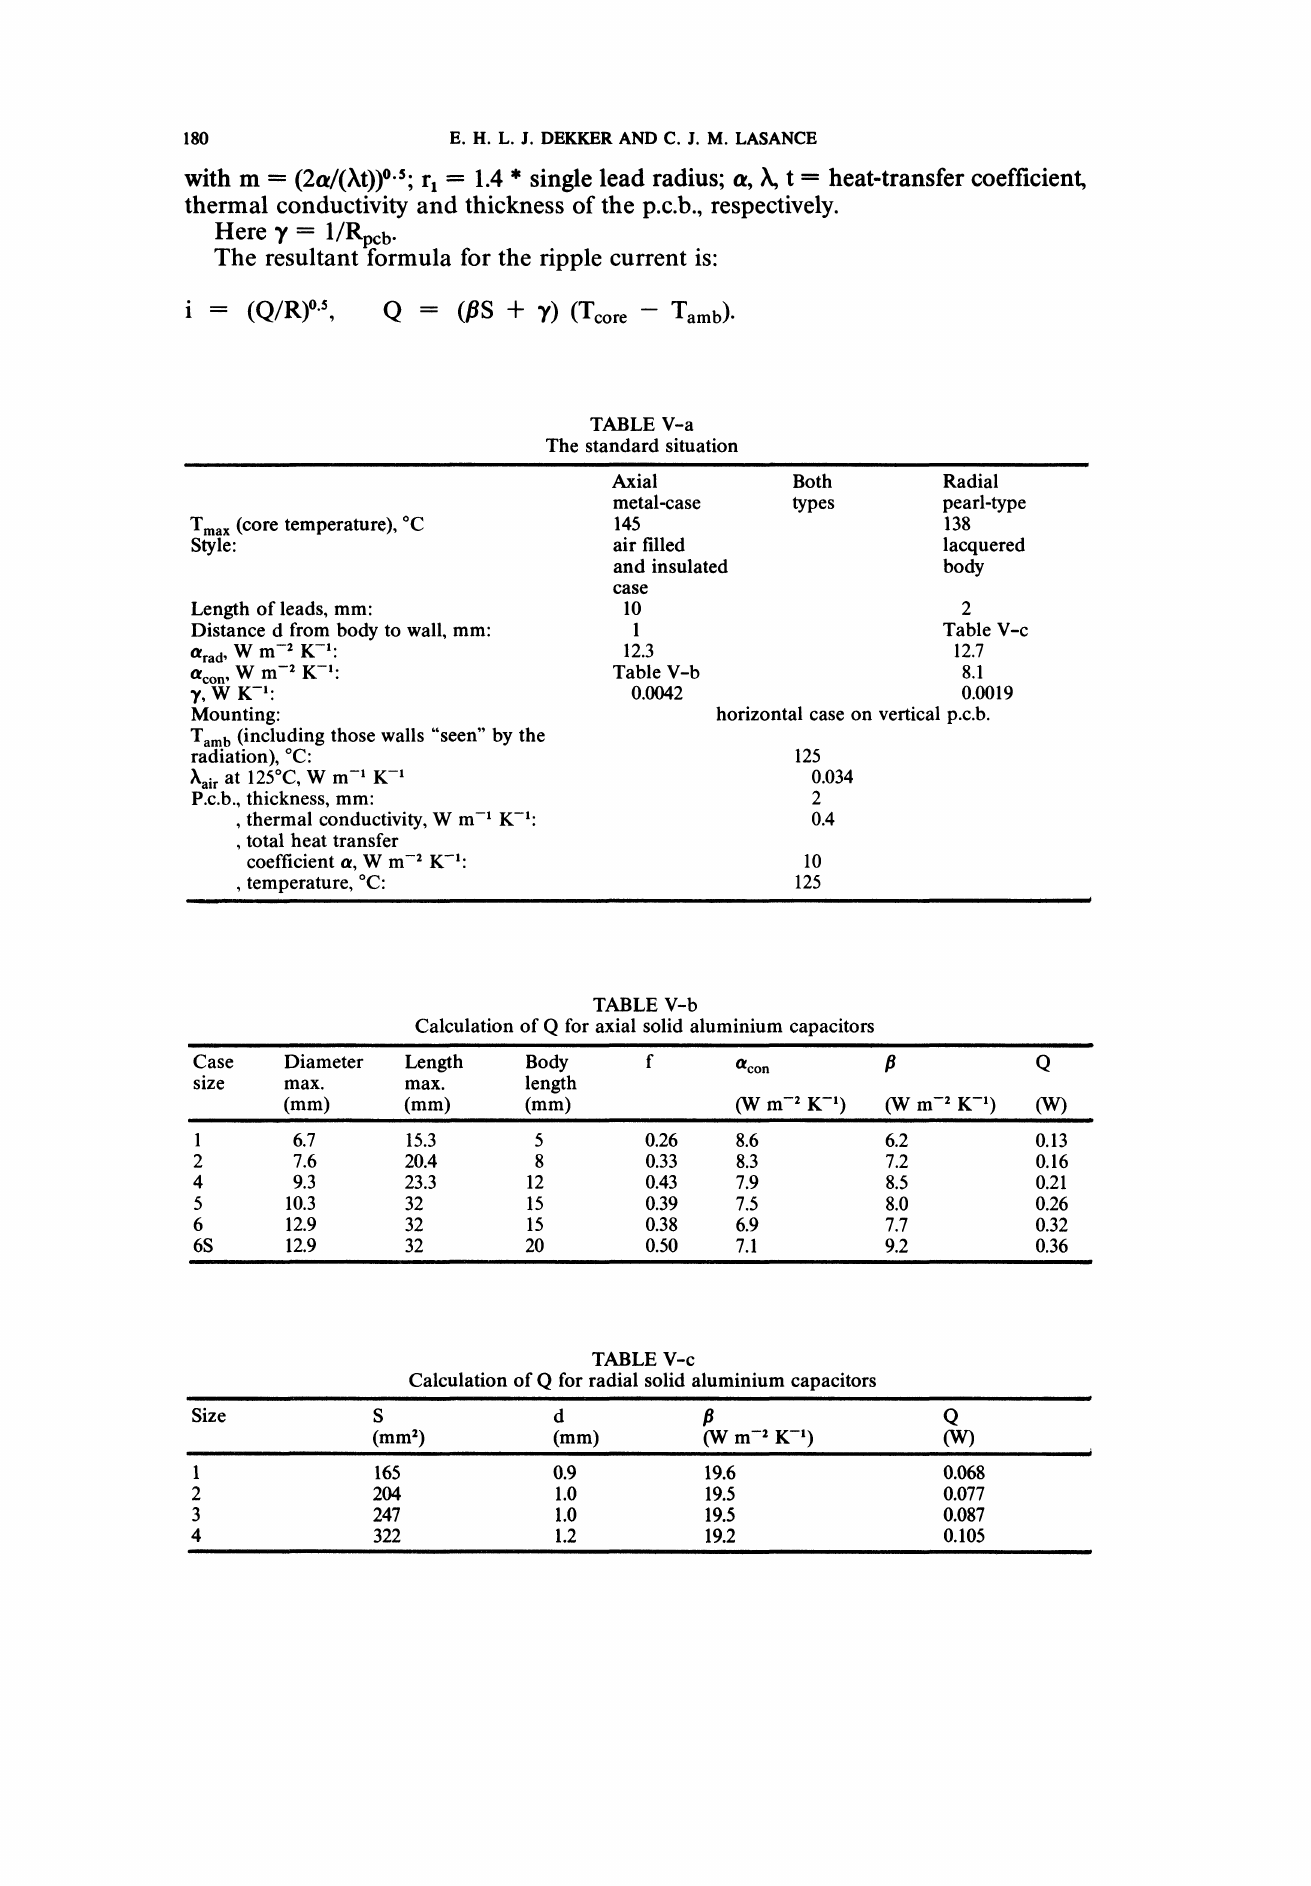
TABLE V-c Calculation of Q for radial solid aluminium